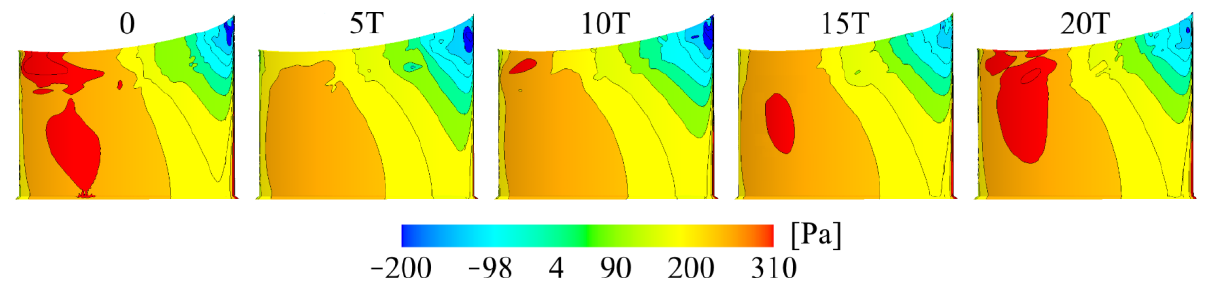
Figure 17. Snapshots of the surface pressure 𝑝 on Blade 3.